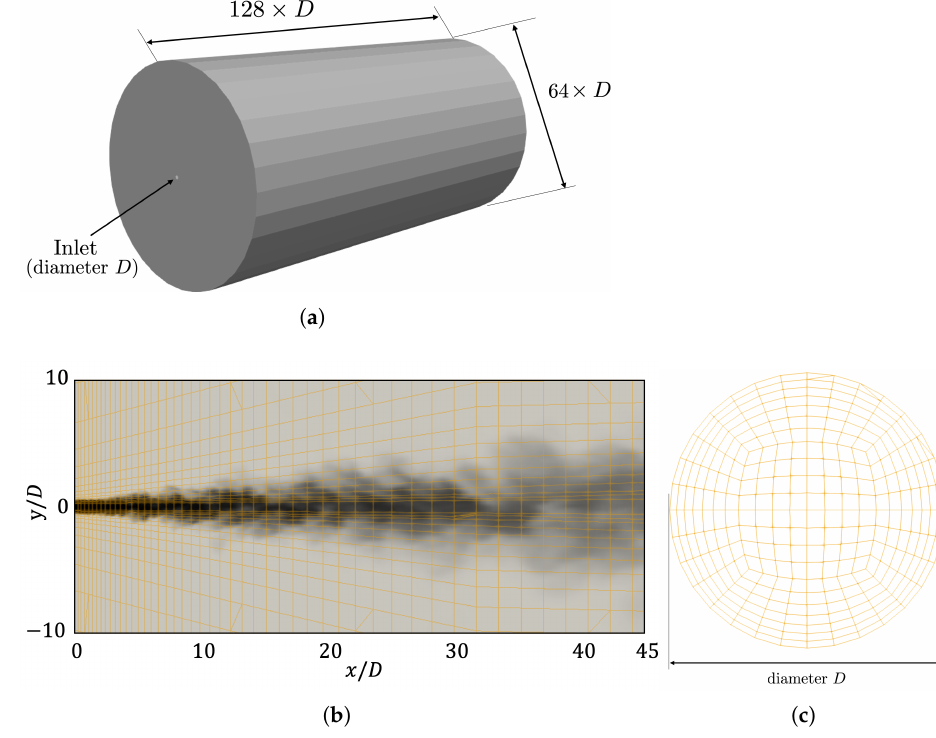
Figure 1. ( a ) Simulation domain; ( b ) grid on the midplane overlaid to the temperature distribution on the midplane; ( c ) grid resolution in the nozzle cross section. To promote visibility only every second grid line is shown. Note that there are graphical artifacts from the visualization using